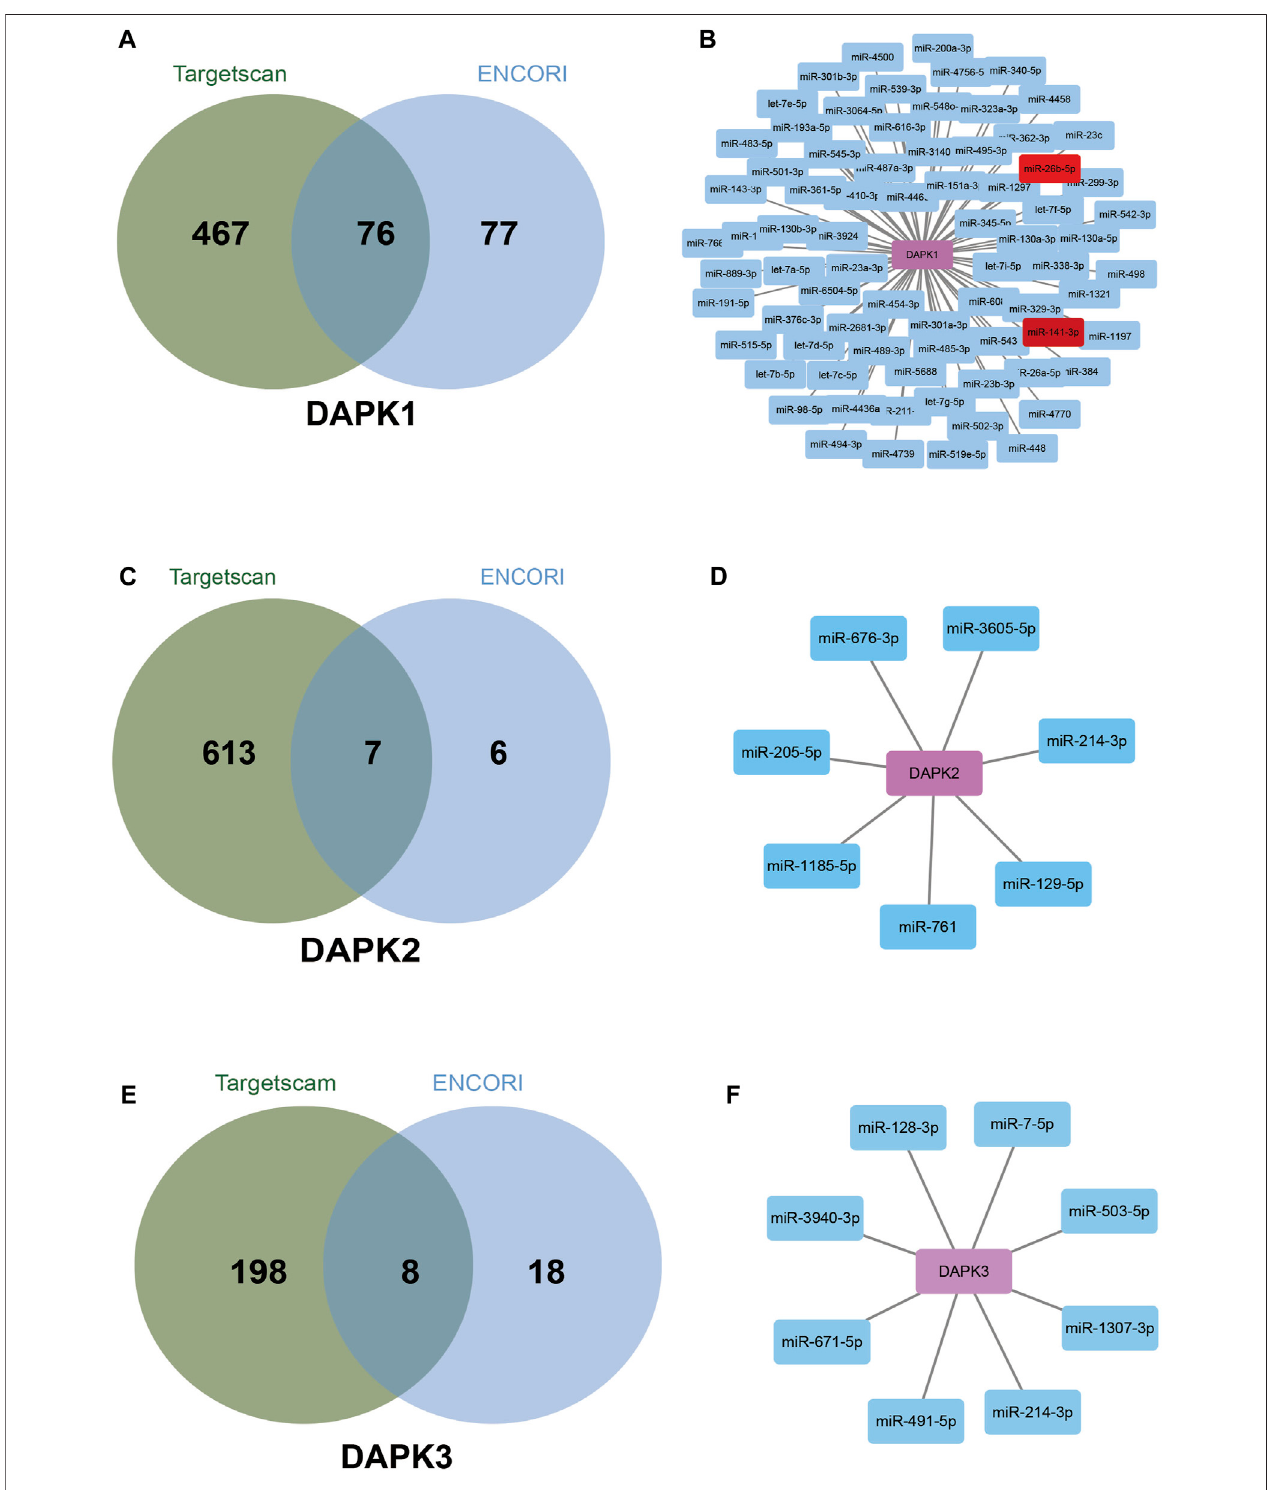
FIGURE 4 | Bioinformatics analysis of potential miRNAs in the regulation of DAPKs. Venn diagrams show potential miRNAs in the regulation of DAPK1 (A) , DAPK2 (C) and DAPK3 (E) based on Targetscan and ENCORI website. Network connection diagram showing potential miRNAs in the regulation of DAPK1 (B) , DAPK2 (D) and DAPK3 (F) based on Targetscan and ENCORI website.